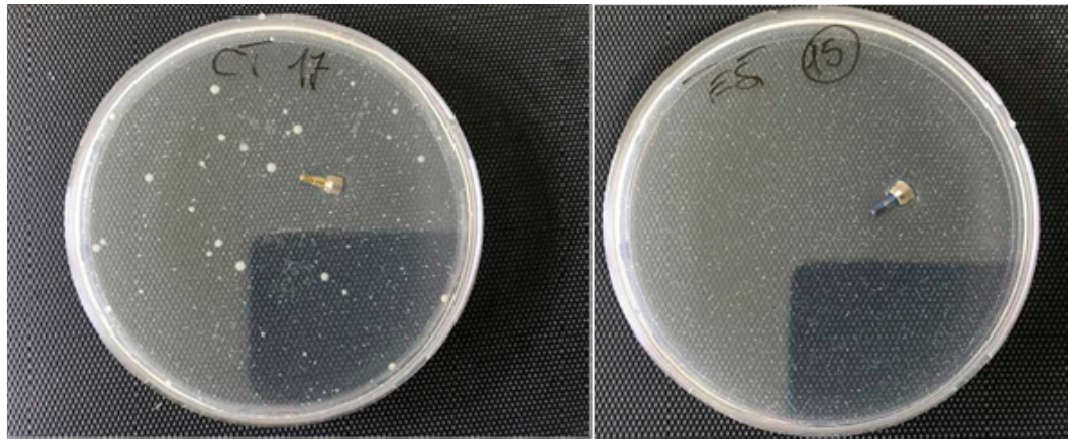
Figure 2. Control ( left ) and test ( right ) healing cups showing the absence of microbial growth in the presence of a contamination of the order of 1–5 × 10 4 cfu of gram positive, gram negative, and Candida.